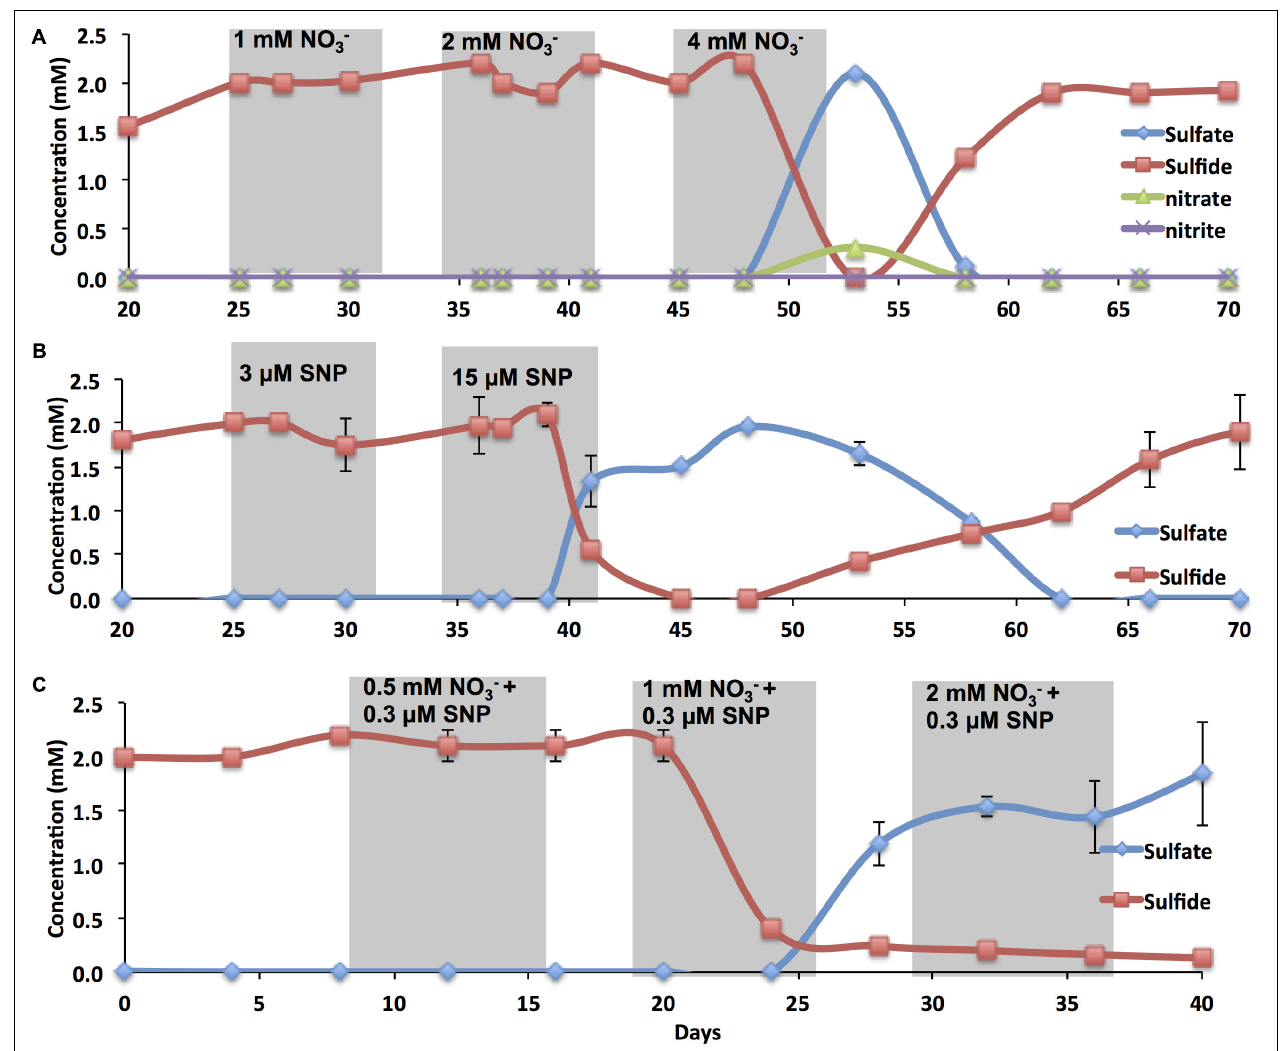
FIGURE 3 | The effect of nitrate and/or SNP on sulfide production in oil-containing bioreactors. Sulfate, sulfide, nitrate, and nitrite concentrations in the effluents of oil-containing bioreactors are shown as indicated. Bioreactors were treated with nitrate (A) , with SNP (B) or with nitrate and SNP (C) . Shaded regions indicate the duration of treatment for injection of 2 PV (240